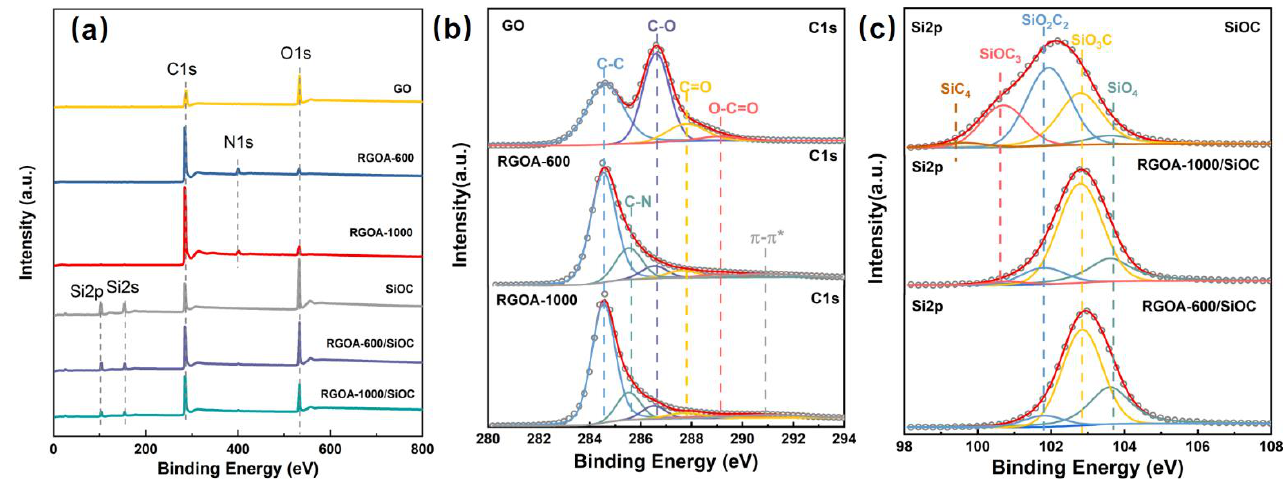
Figure 5. ( a ) Survey X-ray photoelectronic spectra of GO, RGOA, and RGOA-SiOC nanocomposites and SiOC. High-resolution ( b ) C1s spectra of GO, RGOA-600, and RGOA-1000 and ( c ) Si2p spectra of SiOC, RGOA-1000/SiOC, and RGOA-600/SiOC nanocomposites.